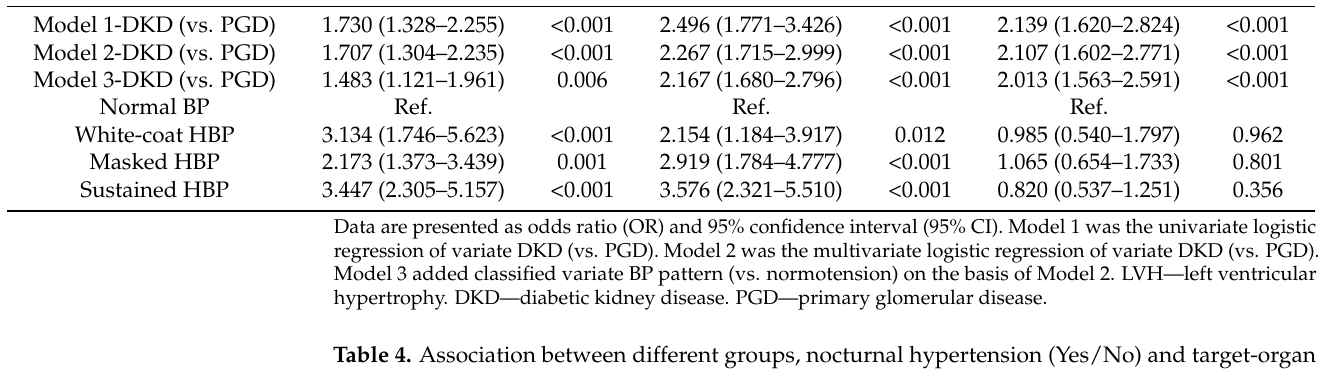
Data are presented as numbers (proportions). * indicates statistic difference compared with the PGD group, p < 0.05. DKD—diabetic kidney disease. PGD—primary glomerular disease. LVH—left ventricular hypertrophy.